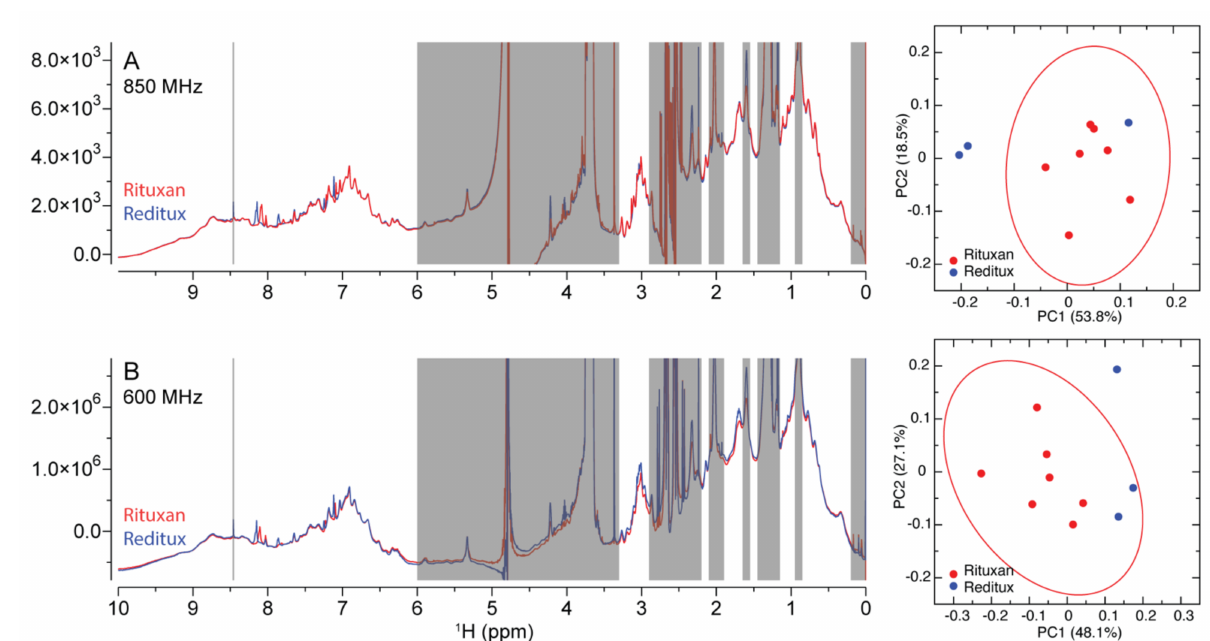
Figure 2. The superimposed 1D 1 H NMR spectra of representative rituximab drug products (DP) of Rituxan ® and Reditux ® collected using 850 MHz ( A , left) and 600 MHz ( B , left) spectrometers. The spectral regions in gray of 0–0.2 ppm, 0.85–0.95 ppm, 1.15–1.45 ppm, 1.55–1.65 ppm, 1.9–2.1 ppm, 2.2–2.9 ppm, 3.3–6 ppm and 8.45–8.47 ppm were excluded before principal component analysis (PCA). The resulting PCA scores for each DP lot from both 850 MHz data ( A , right) and 600 MHz data ( B , right) were plotted along the PC1 and PC2 axes. The 90% confidence ellipses are drawn for Rituxan ® lots only (A/B,